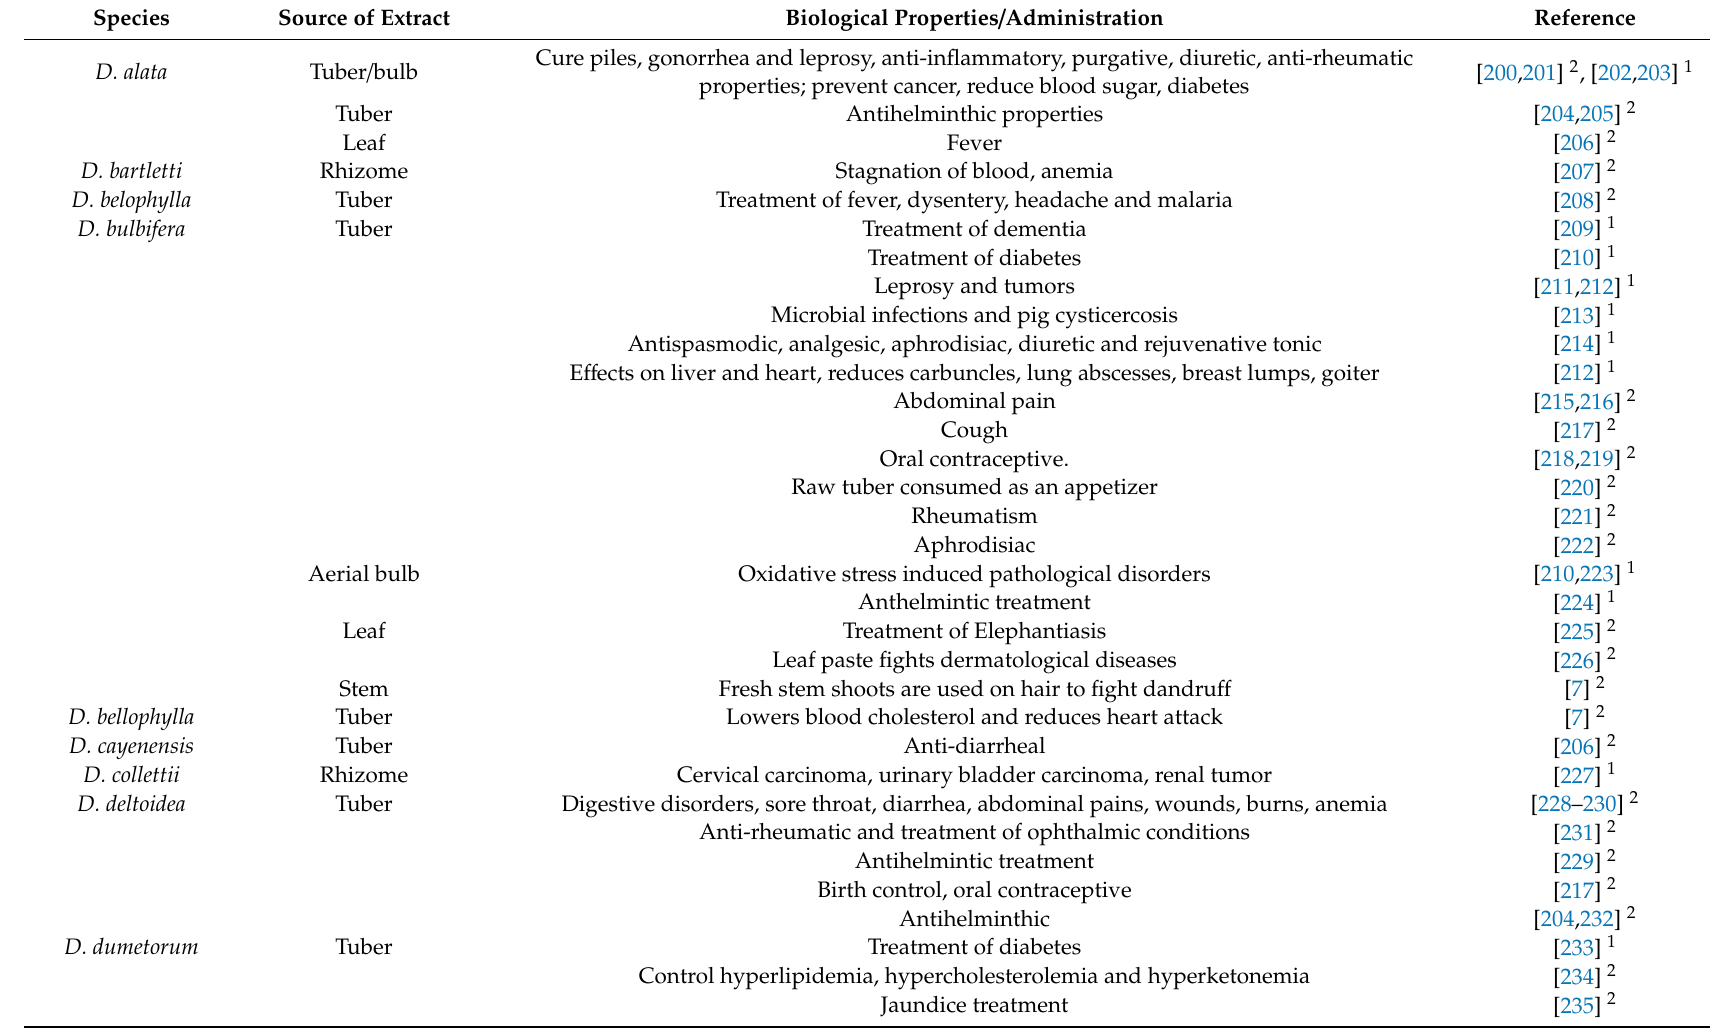
Table 4. Medicinal uses of yam ( Dioscorea